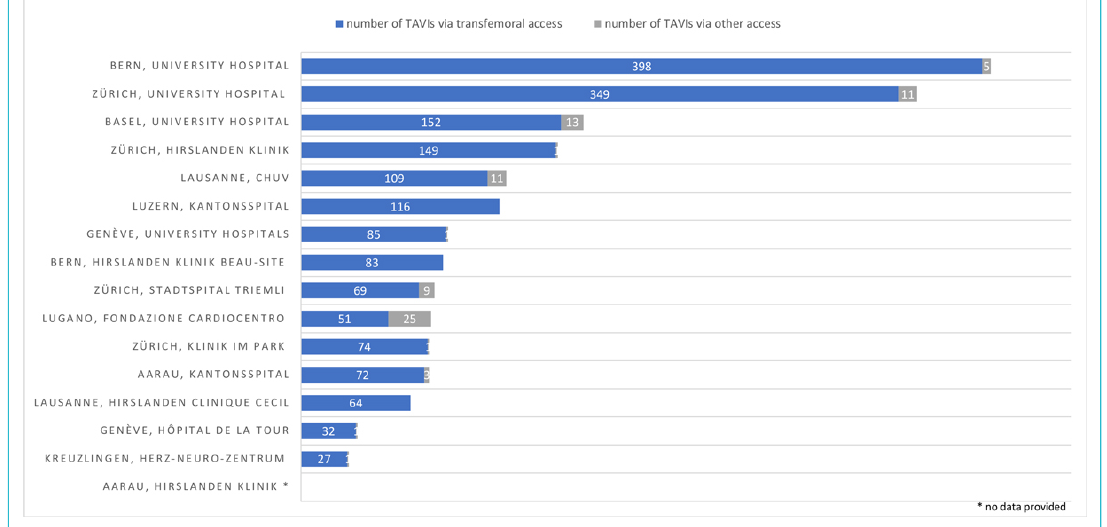
Figure 4: Transcatheter aortic valve implantations in Switzerland 2019 – centres ranked by total number of